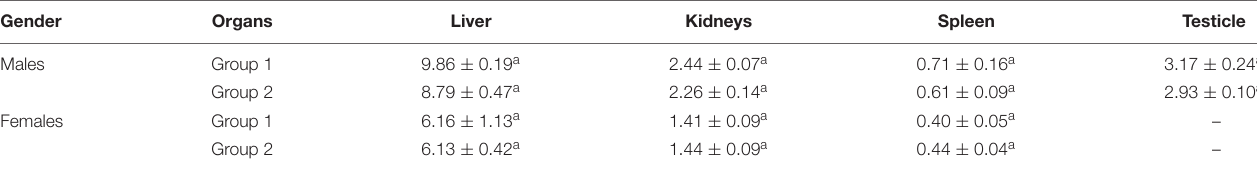
TABLE 3 | The effect of the crude enzymes on organ weights.